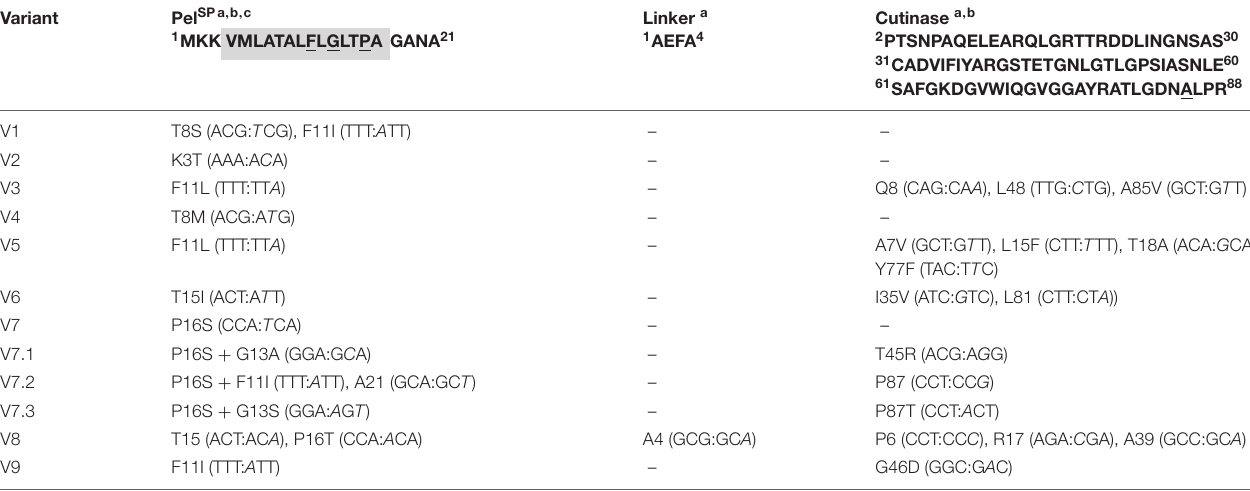
a The DNA coding region that was subjected to random mutagenesis included the Pel SP , the small linker, and a sizeable part of the cutinase (amino acids 2–88); the corresponding amino acids of the respective parts of the wild-type fusion protein are indicated. The altered DNA triplets and the corresponding amino acid changes of the isolated variants are indicated. b Key amino acids that were exchanged by site directed mutagenesis are indicated in bold and underlined. c The putative h-region of the Pel SP is indicated by a gray